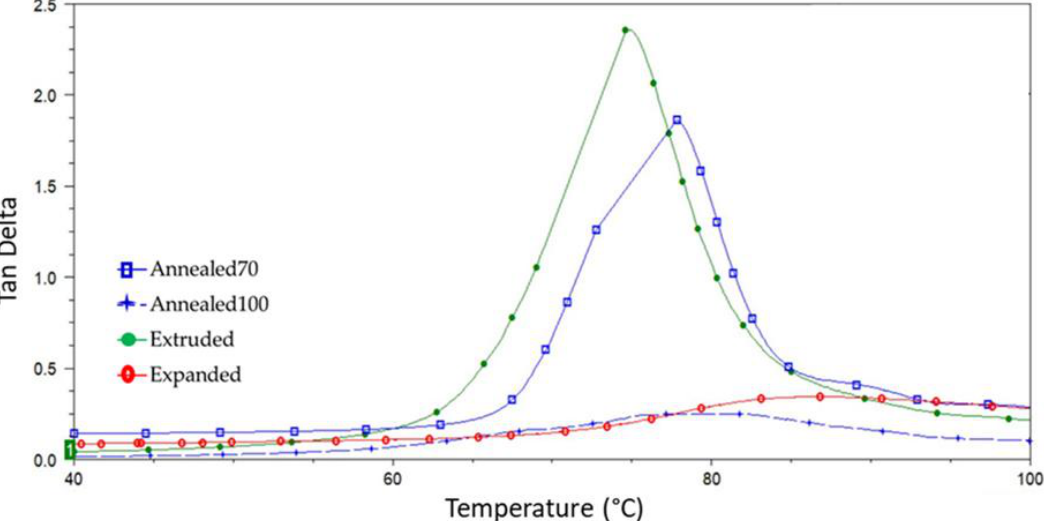
Figure 9. DMA (Dynamic Mechanical Analysis) overlay of the tan delta plots for the Extruded, Annealed70, Annealed100 and Expanded tubing.